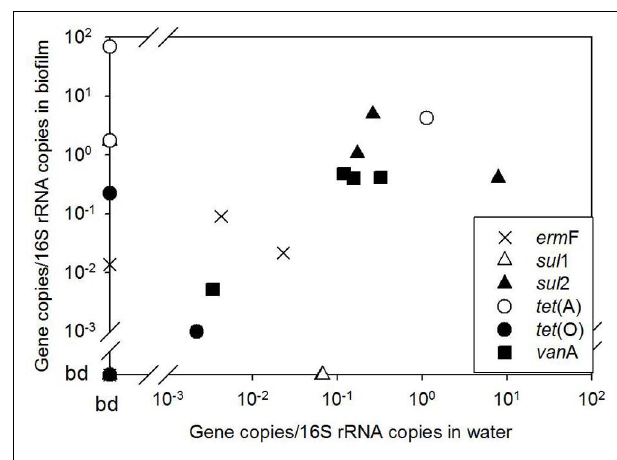
FIGURE 3 | Biofilm versus bulk waterARG copies normalized to 16S rRNA gene copies in available paired biofilm and water samples. ARGs were below detection in several samples, indicated on the x and y axes as